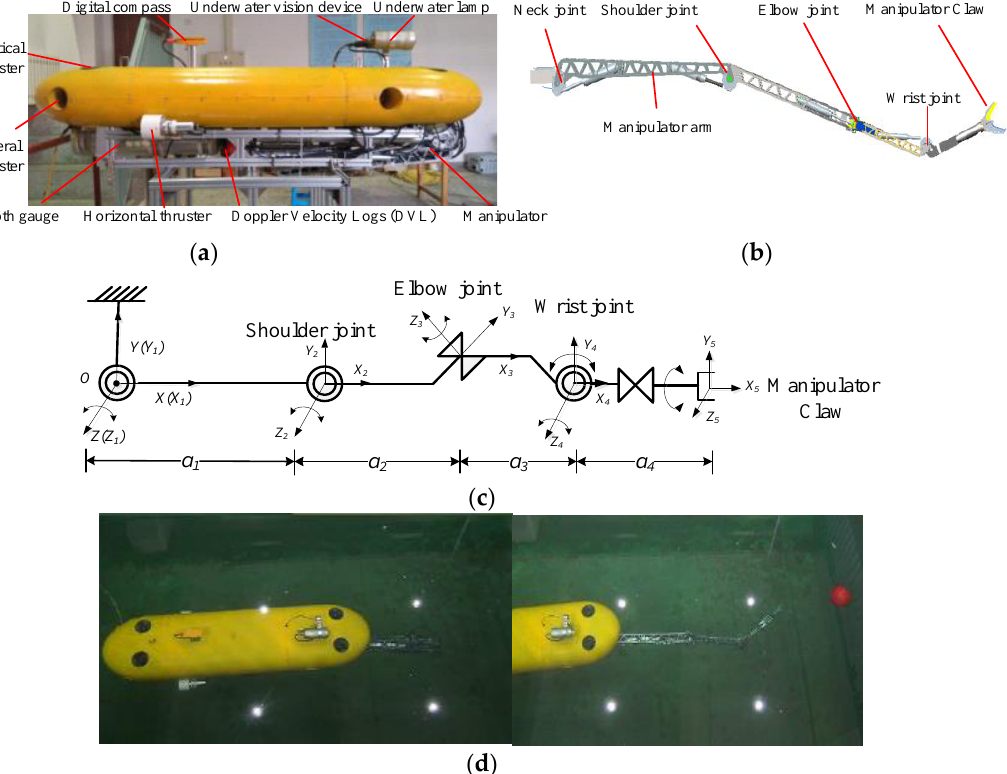
Figure 2. UVIC-I autonomous underwater vehicle (AUV) and its underwater operations. ( a ) The UVIC-I prototype vehicle; ( b ) overall structure of underwater manipulator; ( c ) mechanism diagram of the underwater manipulator; and ( d ) UVIC-I AUV during underwater operations. Table 1. The main parameters of the underwater manipulator.